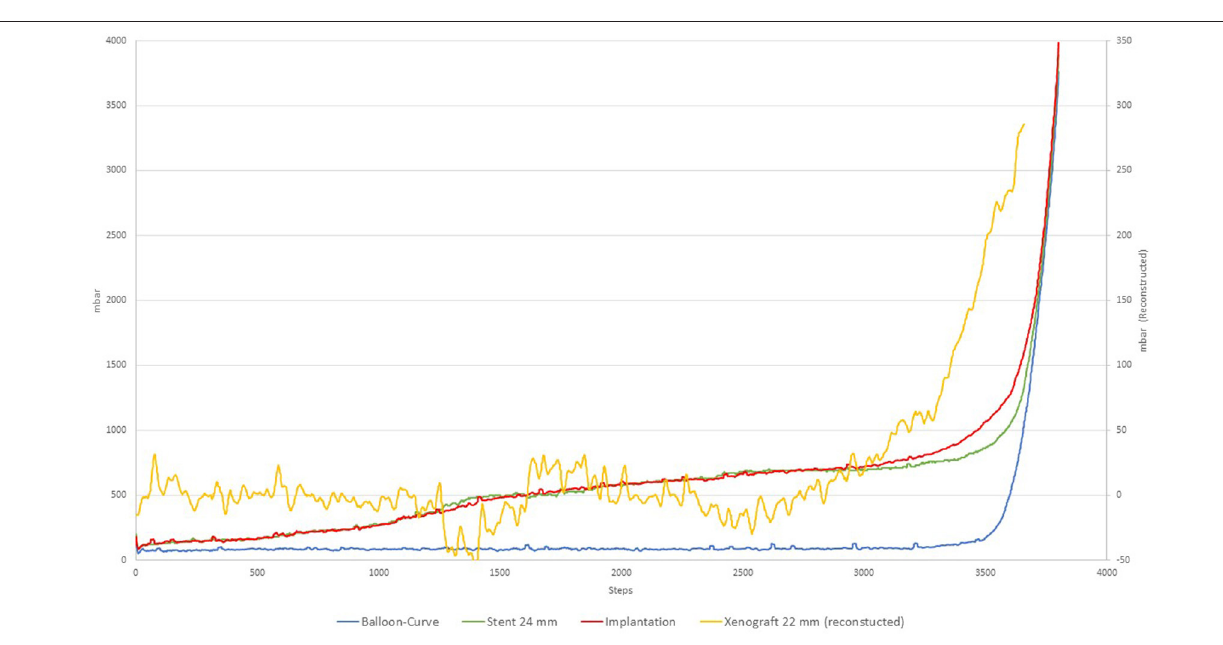
FIGURE 4 | Implantation